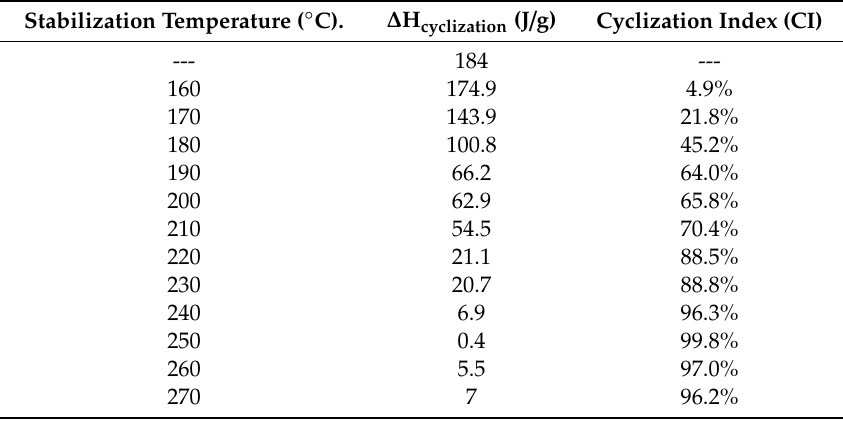
Table 4. Results of thermal analysis of stabilized PAN fibers in inert atmosphere. Stabilization Temperature ( ◦